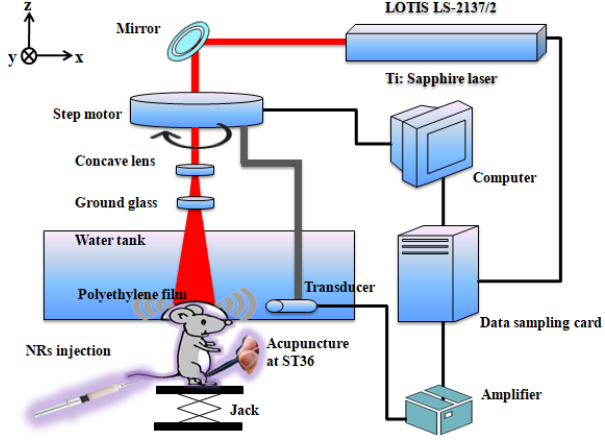
Fig. 1. Schematic of the home-made PAT system for in vivo mouse brain imaging, employing the GNRs contrast agent or acupuncture at